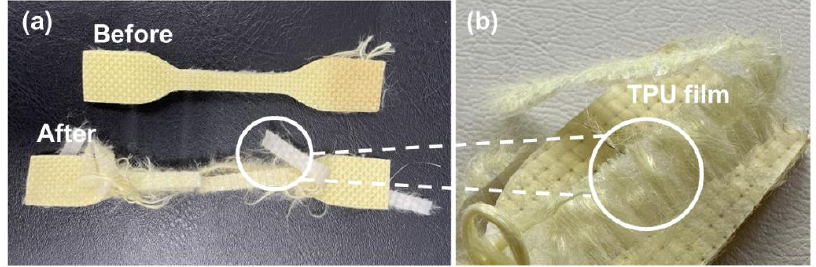
Figure 7. ( a ) Tensile test results and its ( b ) microstructure of Kevlar/TPU laminated composites.